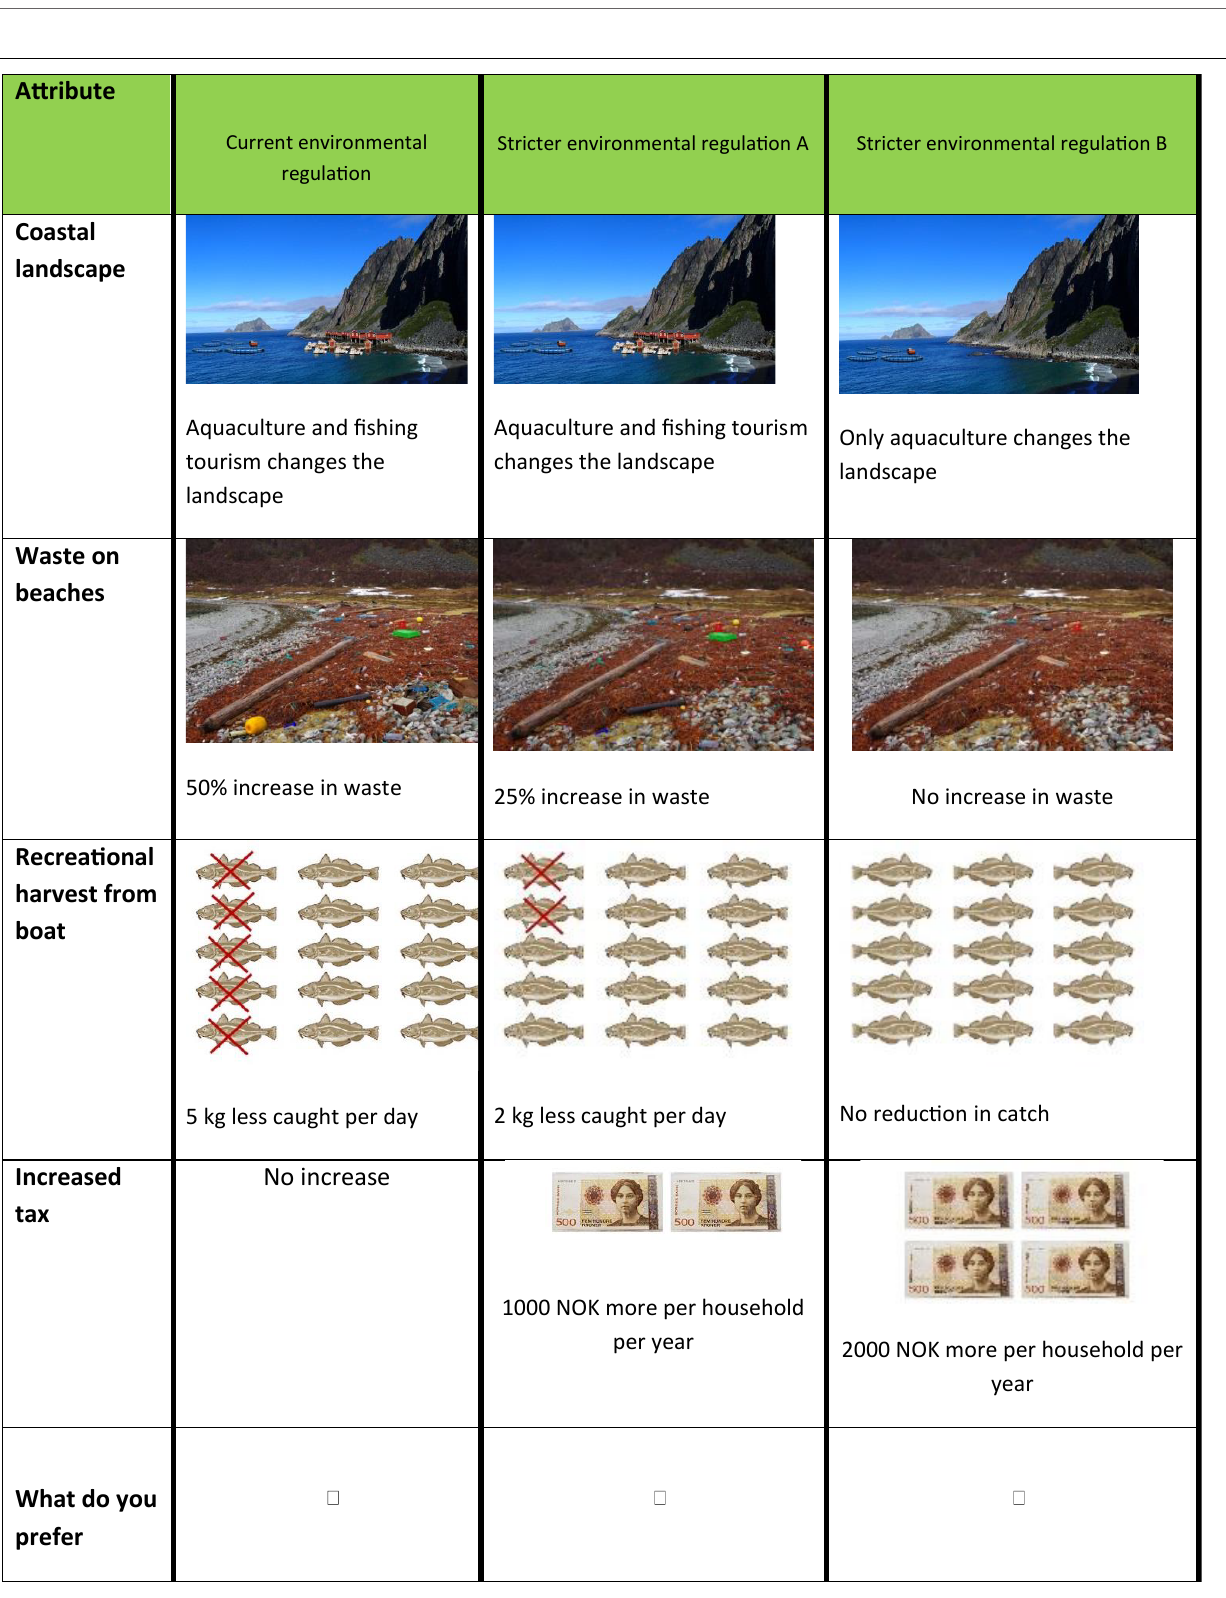
FIGURE A2 | An example of a choice card used in the coastal recreation choice experiment.